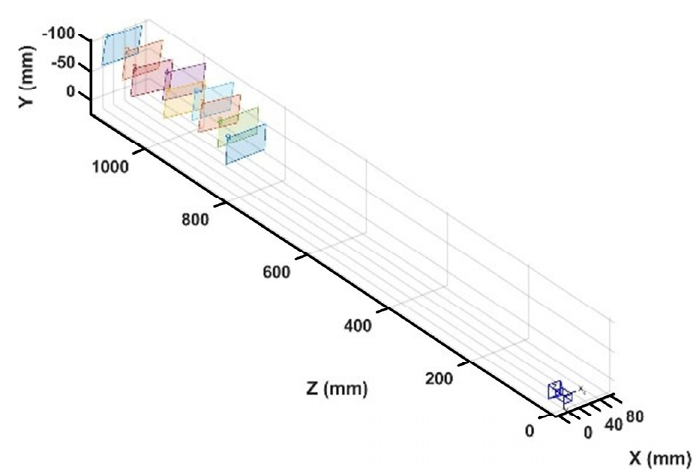
Figure 7. Calibration posture results of light field cameras.